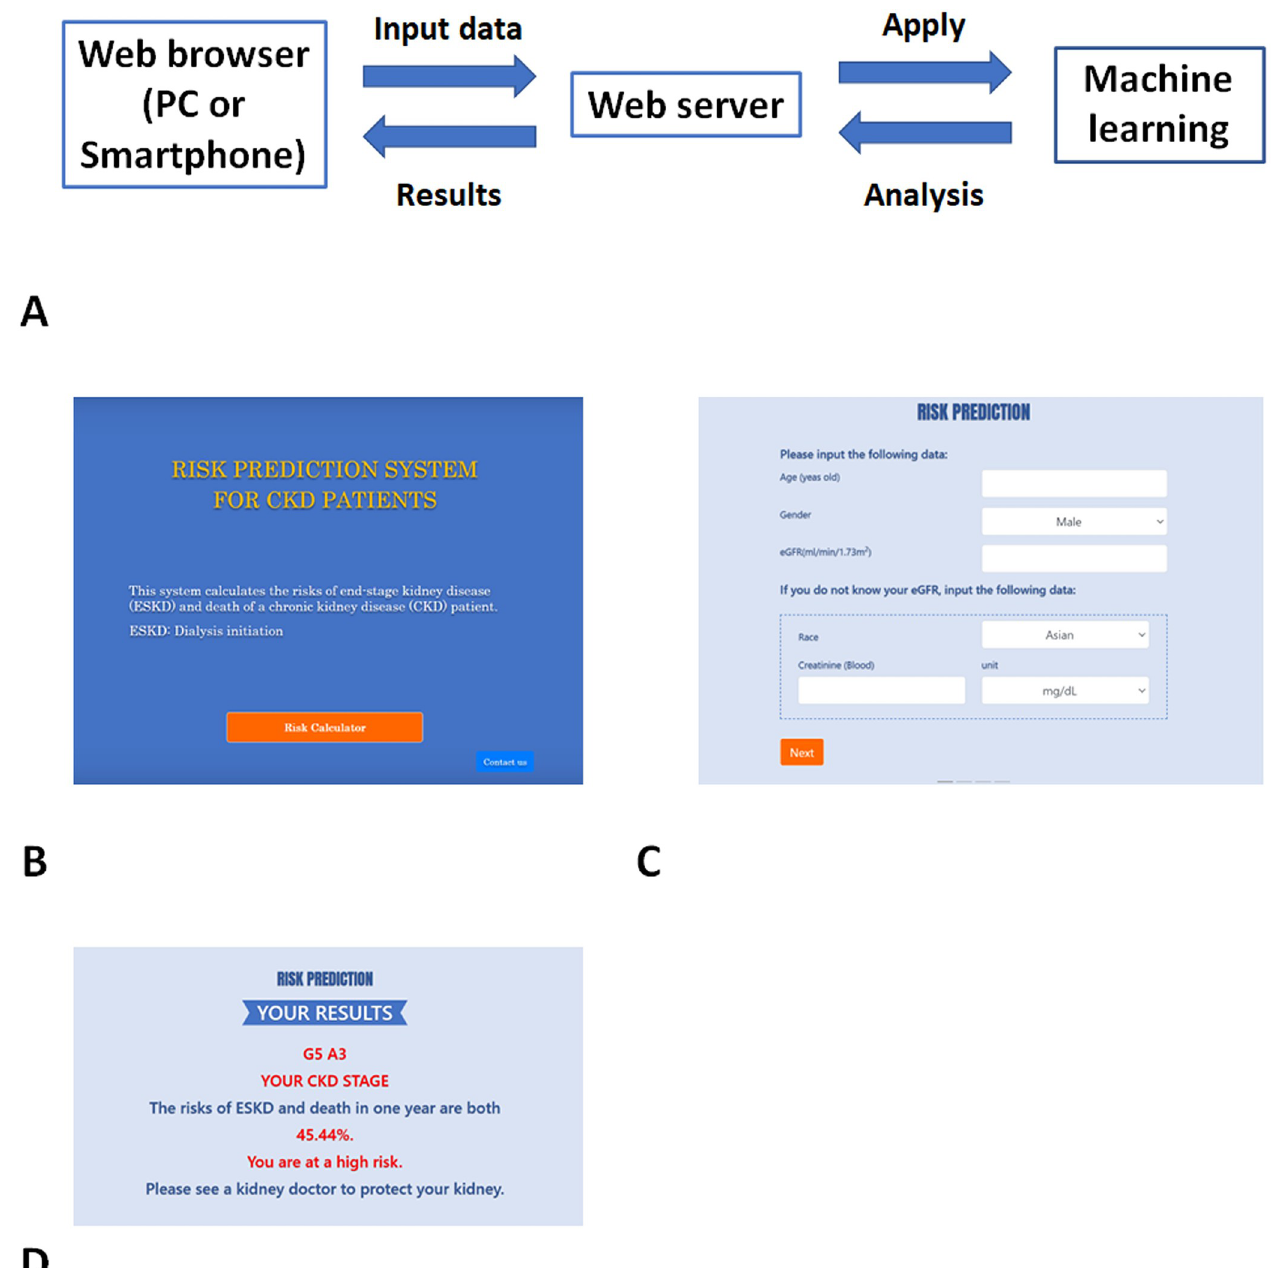
Fig 4. Images of Web pages of risk-prediction system. A. Conceptual design of the system: Patients’ data are input to the machine-learning models. The results are shown on the browser. B. Start page: Go to the Web site, http://160.16.88.112:8000/. C. Input page: Input data of a patient. D. Result page: The expected probability is shown with messages to focus the user’s attention on CKD. Abbreviation: CKD, chronic kidney disease.